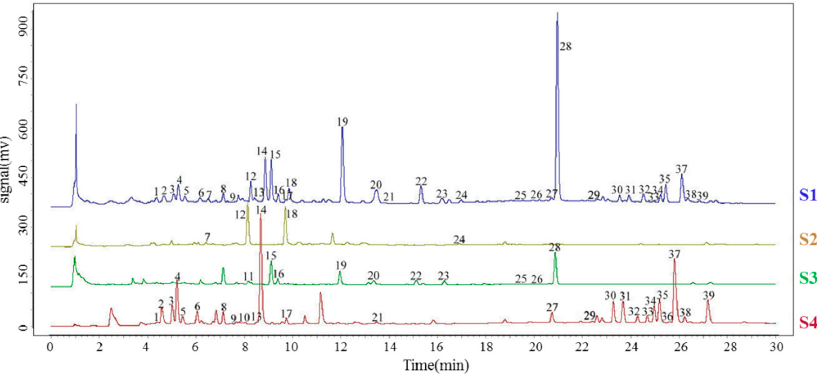
Figure 2. UPLC-UV fingerprint chromatograms of XYLDTs (S1) and three crude herbs, Isodon serra (S2), Andrographis (S3), and Picrasma quassioides (S4).